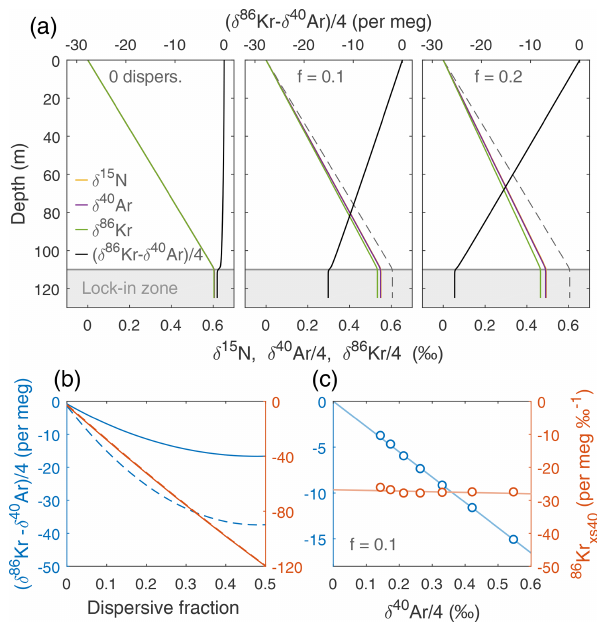
Figure 1. Idealized firn air transport model experiments of 86 Kr xs . Firn density is calculated using Herron and Langway (1980) and the diffusivity using Schwander (1989). (a) Simulations using a fraction of dispersive mixing of f = 0 (left panel), f = 0 . 1 (middle panel), and f = 0 . 2 (right panel) for a hypothetical site with an accumula- tion rate of A = 2cma − 1 ice equivalent and mean annual tempera- ture T = − 60 ◦ C. At dispersive fraction f , effective molecular dif- fusivity of all gases is multiplied by (1- f ) and dispersive mixing for all gases is set equal to f times the effective molecular diffusivity of CO 2 . (b) Isotopic disequilibrium as a function of dispersive mixing intensity at two different firn thicknesses of around 100m (dashed, A = 2cma − 1 and T = − 60 ◦ C) and 50m (solid, A = 2cma − 1 and T = − 43 ◦ C). We compare isotopic disequilibrium without (blue, left axis) and with (orange, right axis) normalization. (c) Simula- tions at 10% dispersive mixing, with each dot representing differ- ent climatic conditions. The accumulation rate is A = 2cma − 1 ice equivalent, and mean annual temperature is changed from − 60 to − 30 ◦ C in steps of 5 ◦